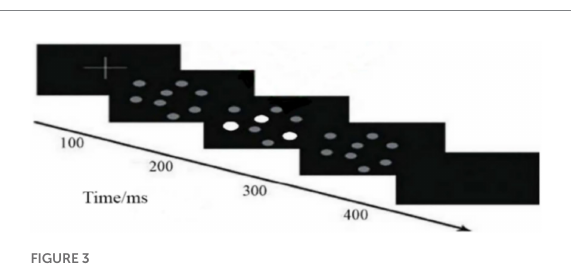
FIGURE 3 A representation of the multiple objective tracking (MOT) task experimental process.